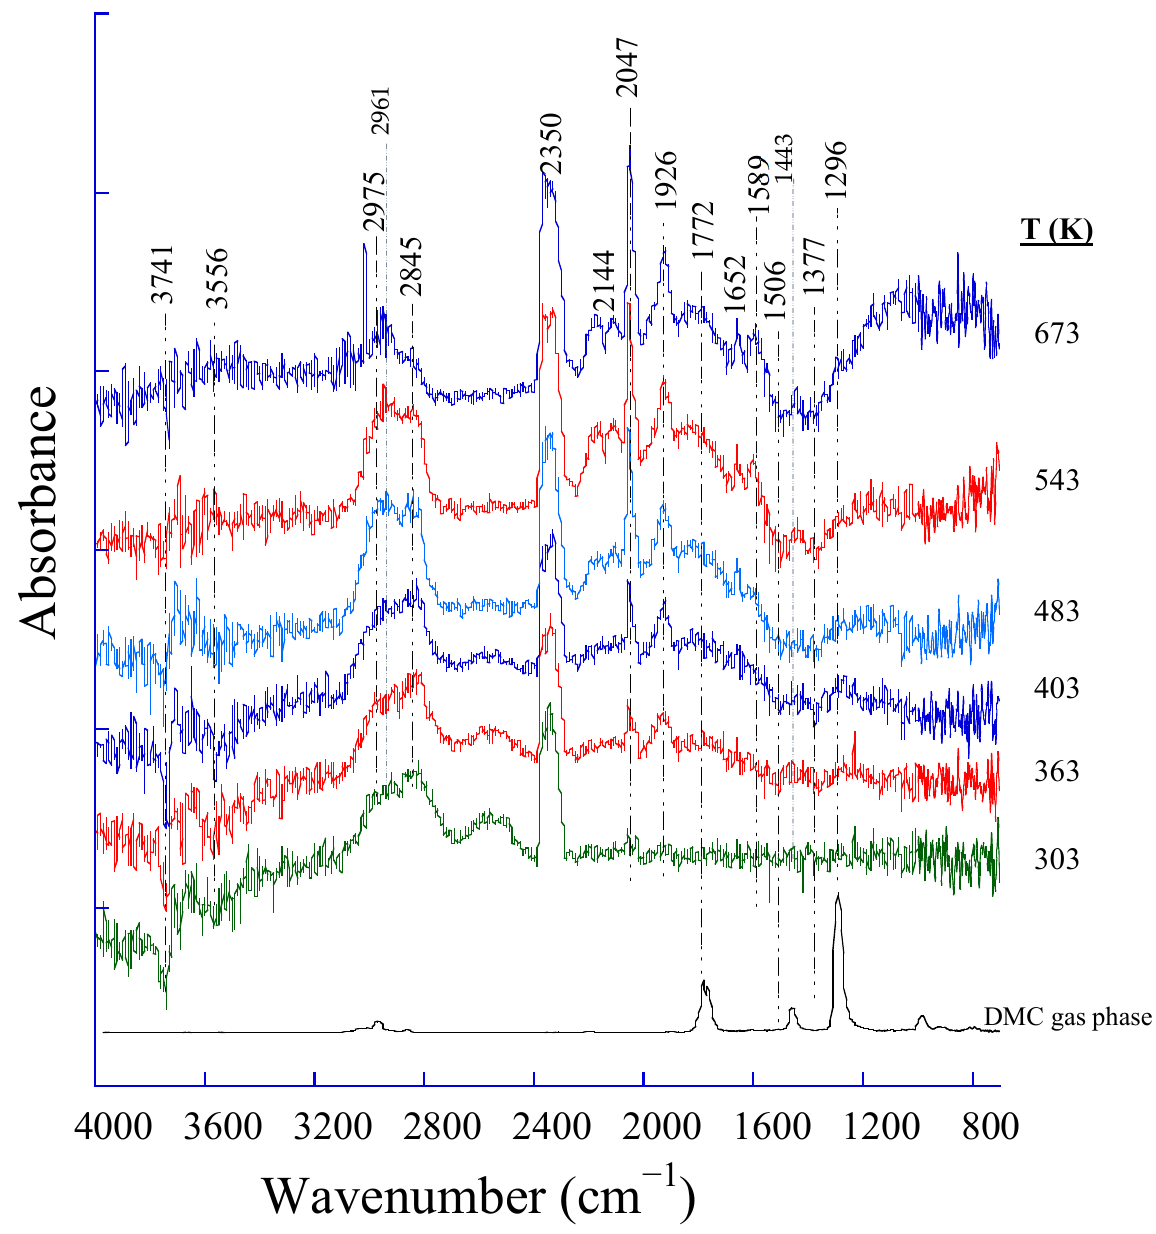
Figure 2- IR spectra during the methanol/CO 2 TPR over Rh/Al 2 O 3. Figure 2. IR spectra during the methanol/CO 2 TPR over Rh/Al 2 O